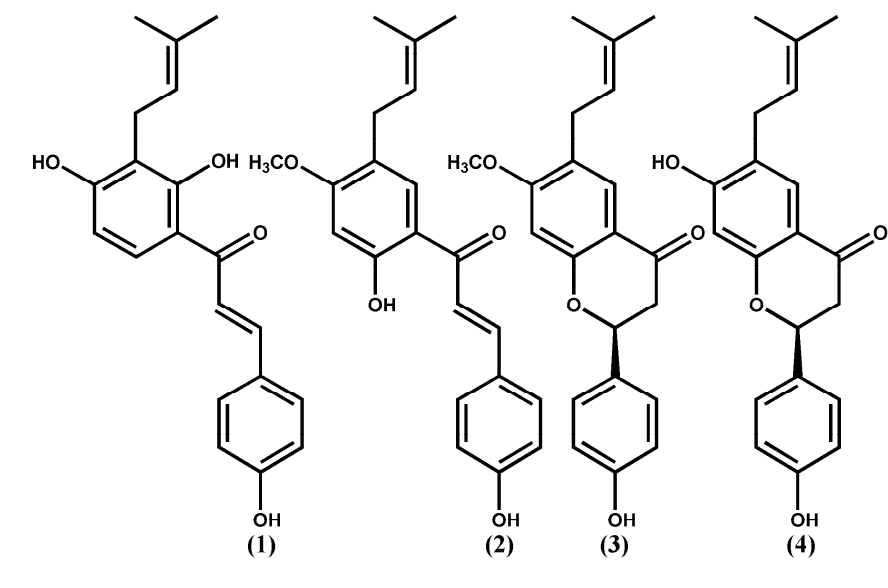
Int. J. Mol. Sci. 2022 , 23 , x FOR PEER REVIEW Figure 3. Chemical structures of compounds 1 – 4 . Figure 3. Chemical structures of compounds 1 – 4 .